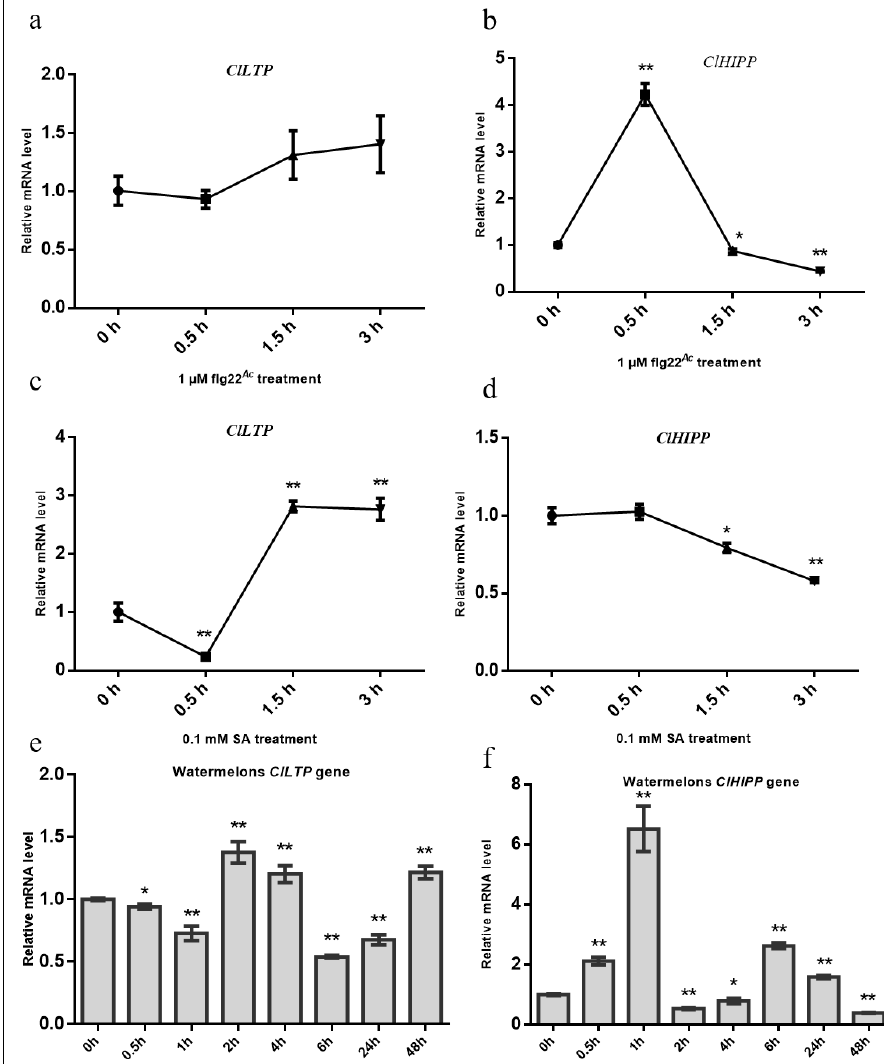
Figure 9. ClHIPP and ClLTP are involved in plant immunity. ( a , b ) Expression patterns of ClHIPP and ClLTP in watermelon at the indicated time points after flg22 Ac treatment. ( c , d ) Expression patterns of ClHIPP and ClLTP in watermelon at the indicated time points after salicylic acid (SA) treatment. Watermelon ACTIN was used as the internal reference gene. The experiment was performed three times, with similar results obtained each time. ( e , f ) Expression patterns of ClHIPP and ClLTP in watermelon at the indicated time points after A. citrulli strain Aac5 infected. Data represent the means ± SD ( n = 3). *, ** above bars indicate significant differences as determined by t-test, p < 0.05.